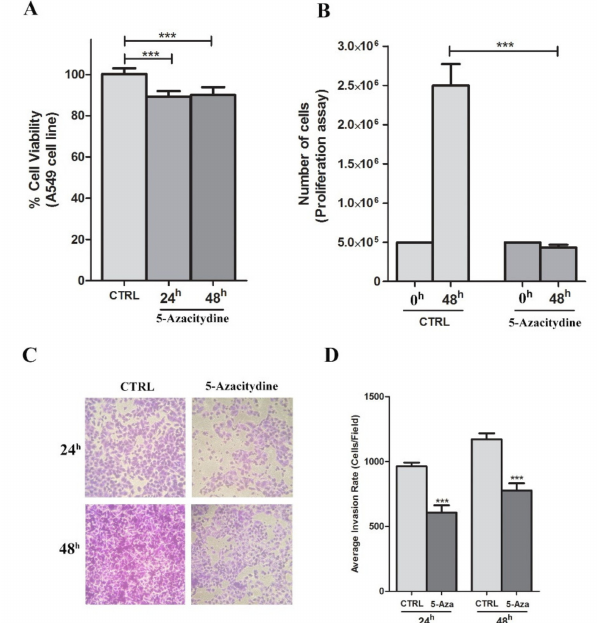
Figure 6. The e ff ects of 5-Aza-Cdr treatment on viability, proliferation and migration of A549 cell line. ( A ) Results from the viability assay performed using PrestoBlue assay after 5-Aza-Cdr treatment. Data are expressed as mean ± SEM vs. ctrl. ( B ) Results from the proliferation assay after 5-Aza-Cdr treatment. Data are expressed as mean ± SEM ( n = 4). *** p < 0.001 vs. untreated samples ( t -test). ( C ) Photographs of representative fields of stained cells that migrated through the membrane during the invasion assay after 24 and 48 h of incubation. ( D ) Columns represent the average of the number of cells per field of at least ten fields in three independent experiments of invasion assay. Data are expressed as mean ± SEM. *** p < 0.001 vs. untreated samples ( t